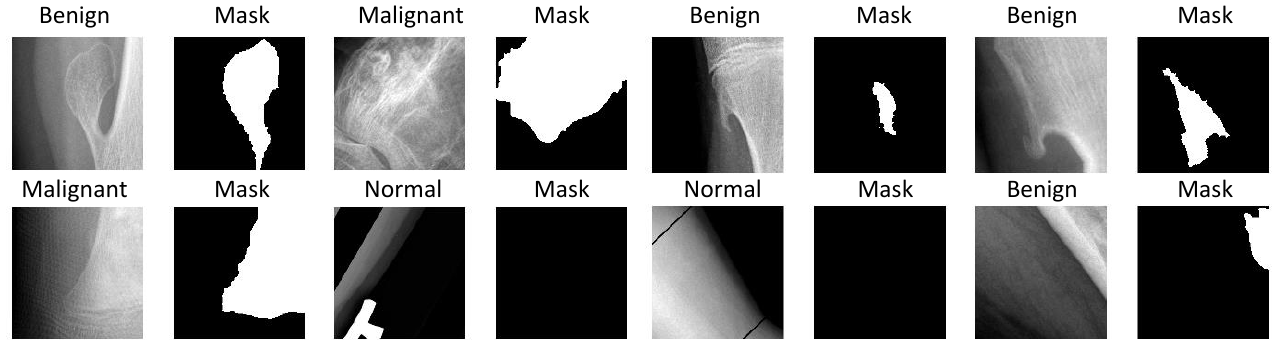
Figure 8. Data augmentation in the global-based model with transform operators such as resizing, rotating, center cropping, and flipping randomly.